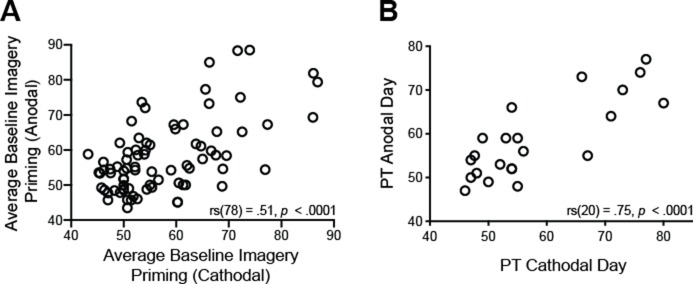
Re-test reliability for imagery strength (A) and Phosphene Thresholds (B).(A) Scatterplot shows participants’ imagery strength measured by percent of binocular rivalry displays primed before tDCS stimulation across 2 days of testing (pre-anodal and pre-cathodal stimulation). Each data point represents one participant, 79 pairs in total. (B) Scatterplot shows participants’ 60% phosphene thresholds (PT) before tDCS stimulation across the 2 days of testing. Each data point represents one participant, 21 pairs in total.